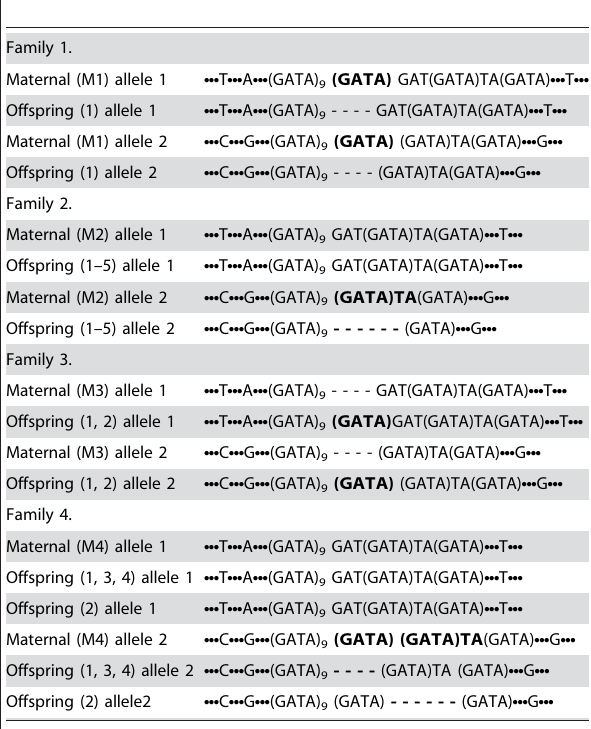
Table 1. Allelic variants of microsatellite clusters of Du281 locus in parthenogenetic lizard families D. unisexualis